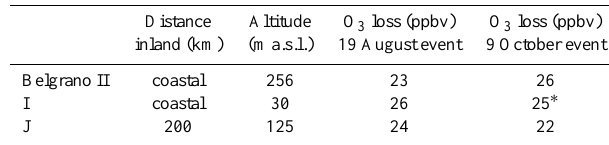
Fig. 10. Surface ozone time series (10 min averages) from three low Figure 10. Surface ozone time series (10 min averages) from three low altitude sites; I and J, both on 627 altitude sites; I and J, both on the Filchner Ice Shelf but with J inland the Filchner Ice Shelf but with J inland and I on the coast; and Belgrano II, on the coast near site I. 628 and I on the coast; and Belgrano II, on the coast near site I.